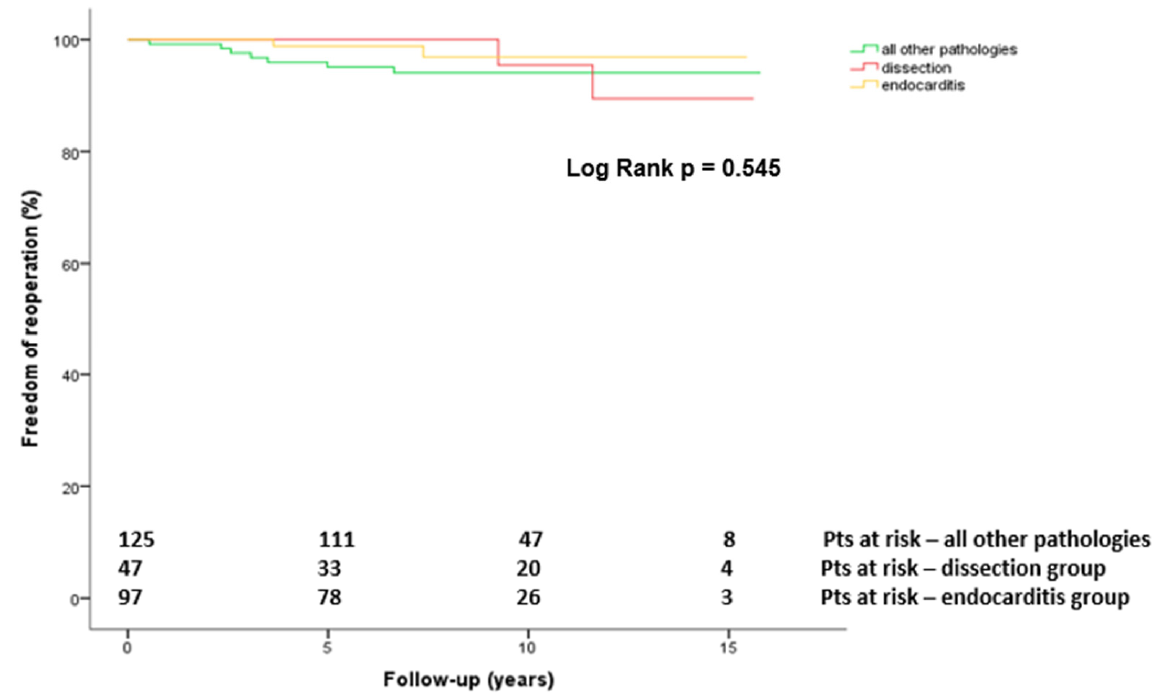
Figure 5. Kaplan–Meier estimated freedom of reoperation after Bentall–De Bono operation in dissection vs. endocarditis vs. other pathologies group. Pts: patients.